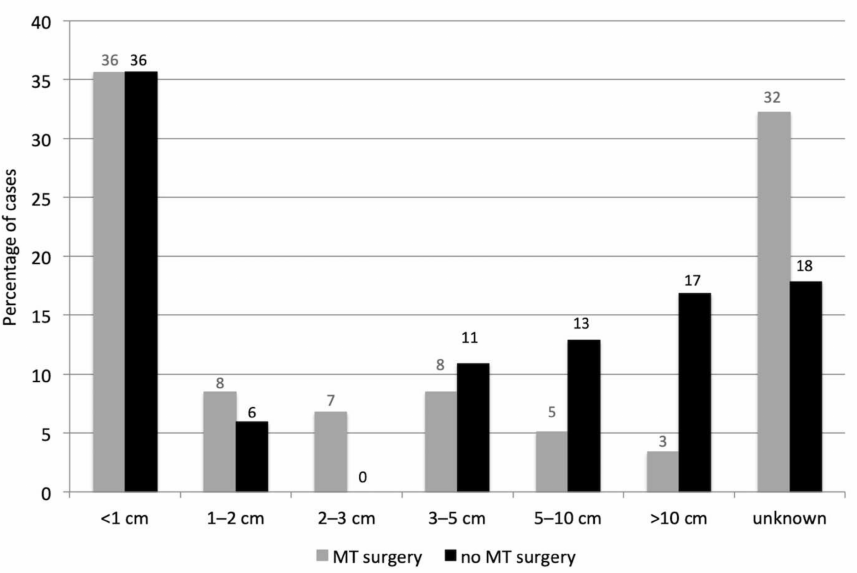
Figure 1. Mammary tumor size in female dogs that benefited or not from a